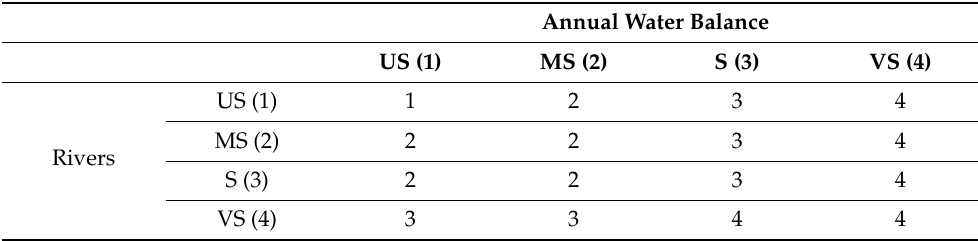
Table 2. Matrix for the combined suitability classification of water availability from the “Annual water balance” and “Rivers and Streams” classified into the suitability scale